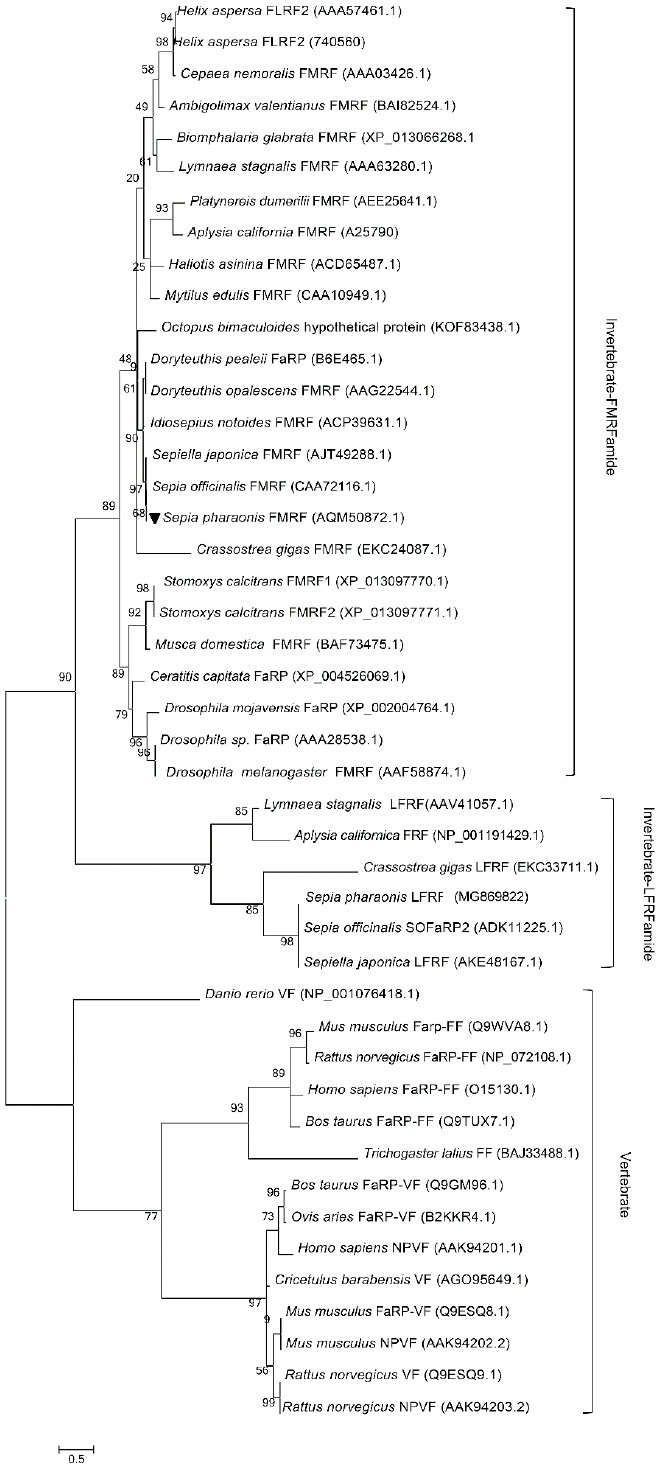
Figure 3. Phylogenetic tree constructed with Sp FMRFamide which was noted by ▼ and 44 kinds of other identified RFamide precursors by the maximum likelihood method (MEGA 6.0). All protein sequences were obtained from GenBank of the US National Center for Biotechnology Information (NCBI), and the GenBank accession numbers are in parentheses. The topological stability of the tree was achieved by running 1000 bootstrapping replications. Bootstrap values (%) are indicated by numbers at the nodes. The scale for branch length is shown below the